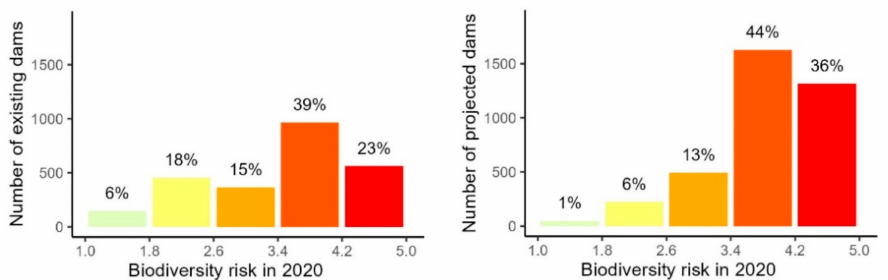
Figure 13. Distribution of biodiversity risk, based on species richness and endemism of freshwater fish, in the locations of existing hydropower dams ( left ) and where projected hydropower dams are planned ( right ). Note that biodiversity risk is only expressed in terms of 2020 data, so here we describe the current status of fish endemism and fish richness of basins where projected dams will be potentially located, not a projection of future biodiversity status.